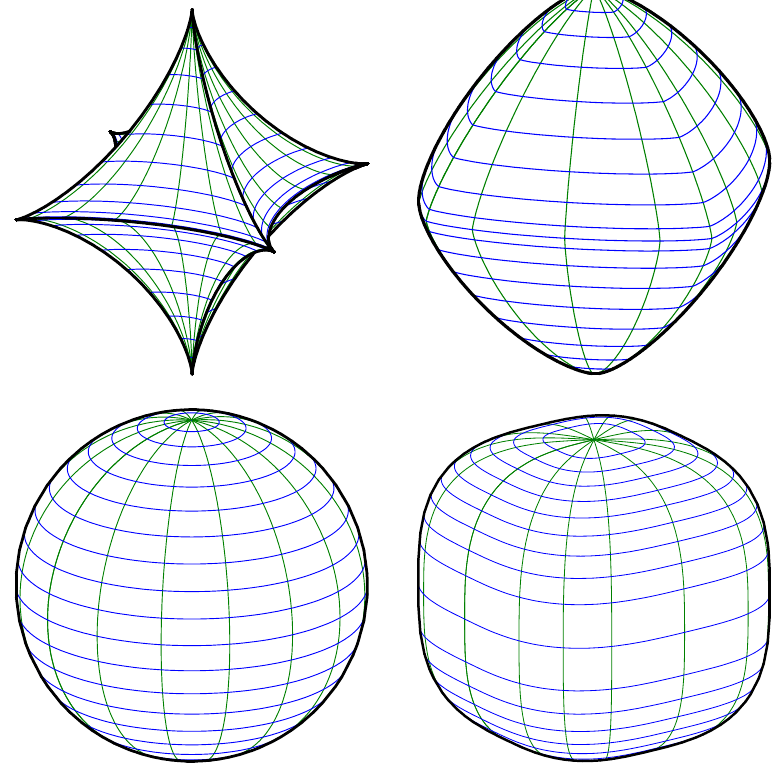
Figure 6. Spheres with respect to the metric of (cid:96) 0.7 and the norms of (cid:96) 1.3 , (cid:96) 2 , and (cid:96) 3 . If the exponents are different, the shape of the sphere is more interesting. We consid- ered the unit sphere with the identity matrix A . On the left in Figure 7, the exponents are p 1 = 4, p 2 = 0.8, p 3 = 1, and on the right, they are p 1 = 1, p 2 = 0.8, p 3 =